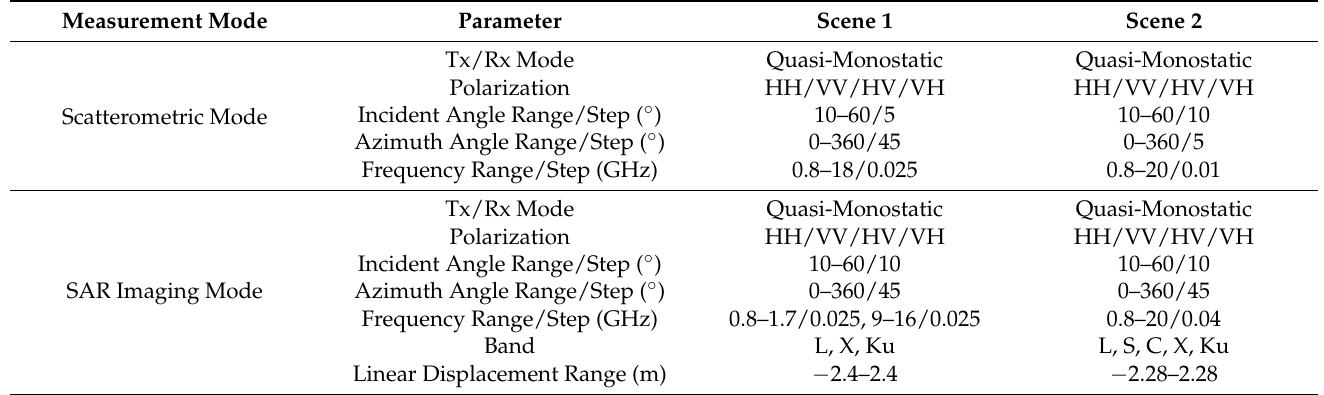
Table 2. Measurement parameters of the two rice field